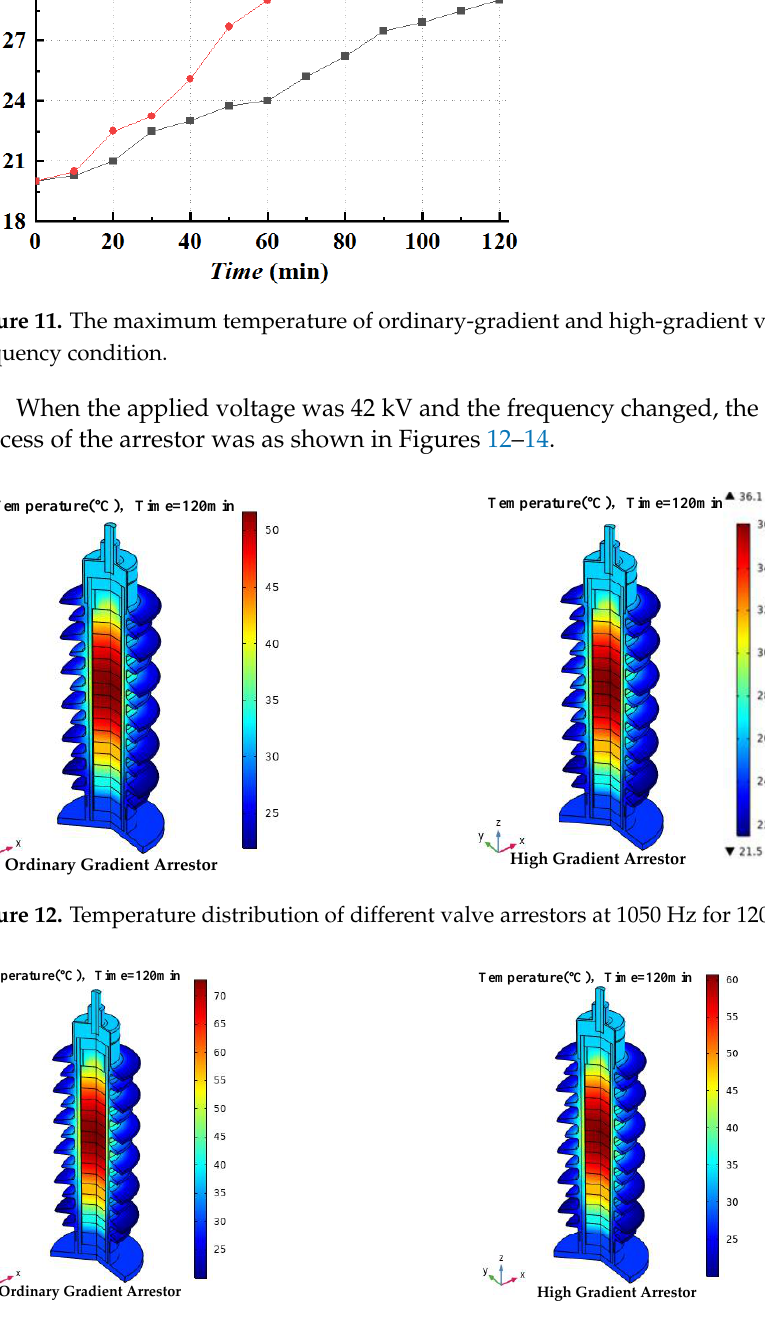
Figure 13. Temperature distribution of different valve arrestors at 2050 Hz for 120 min.